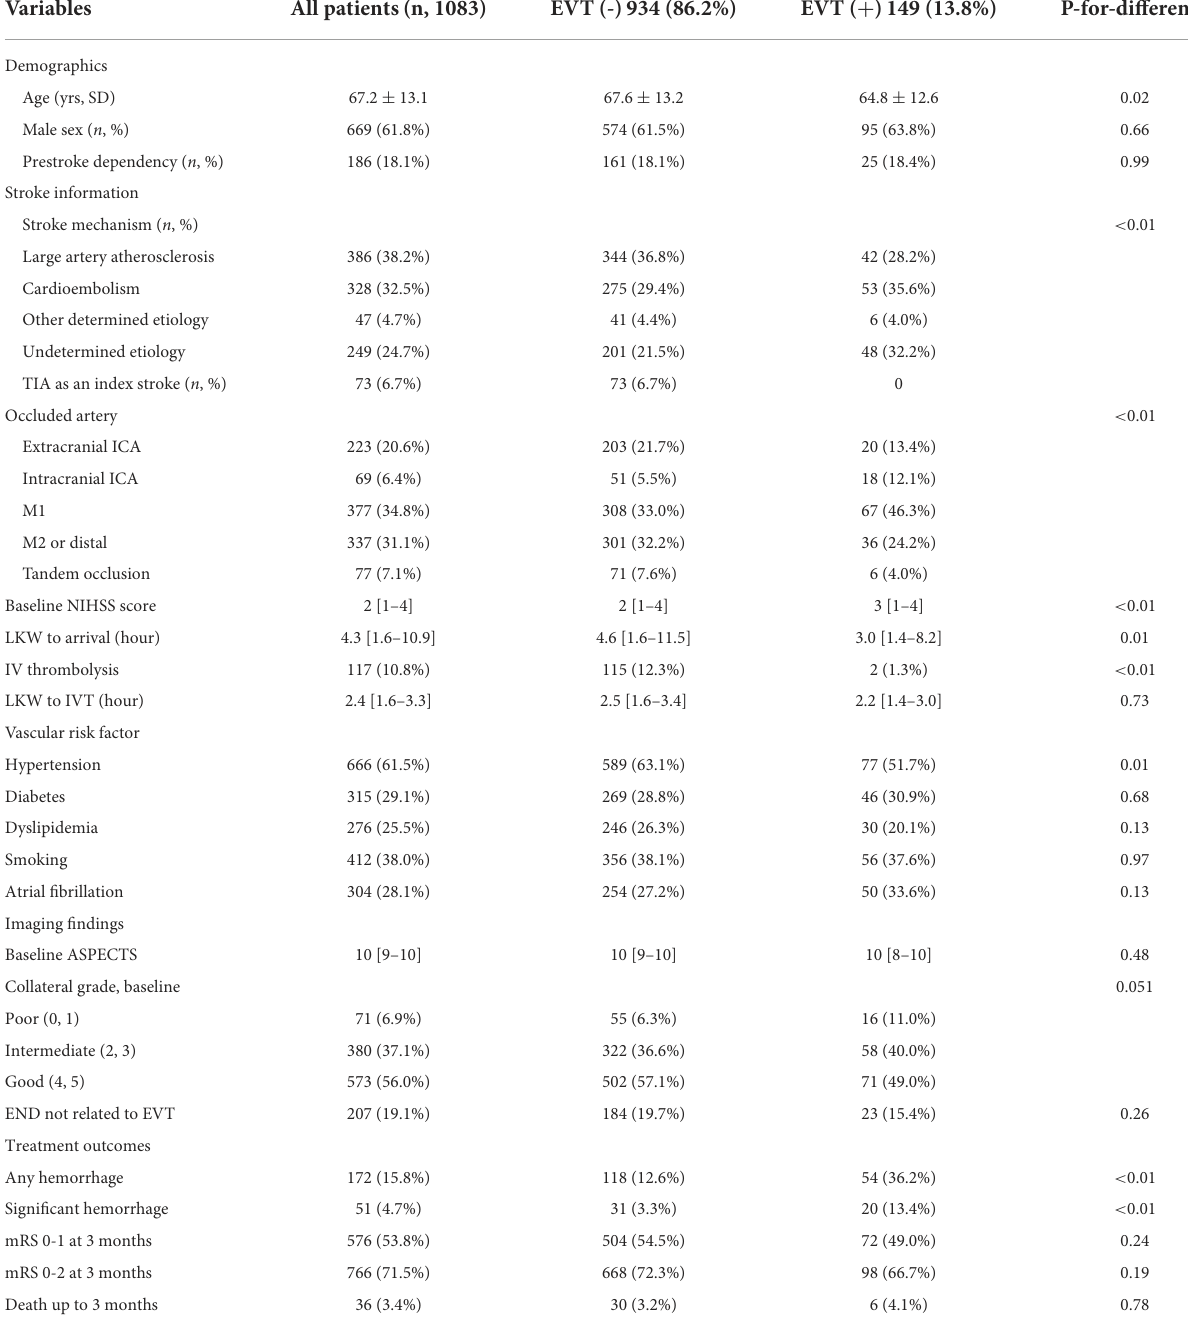
TABLE 1 Clinical profiles of patients stratified according to patients receiving or not receiving endovascular